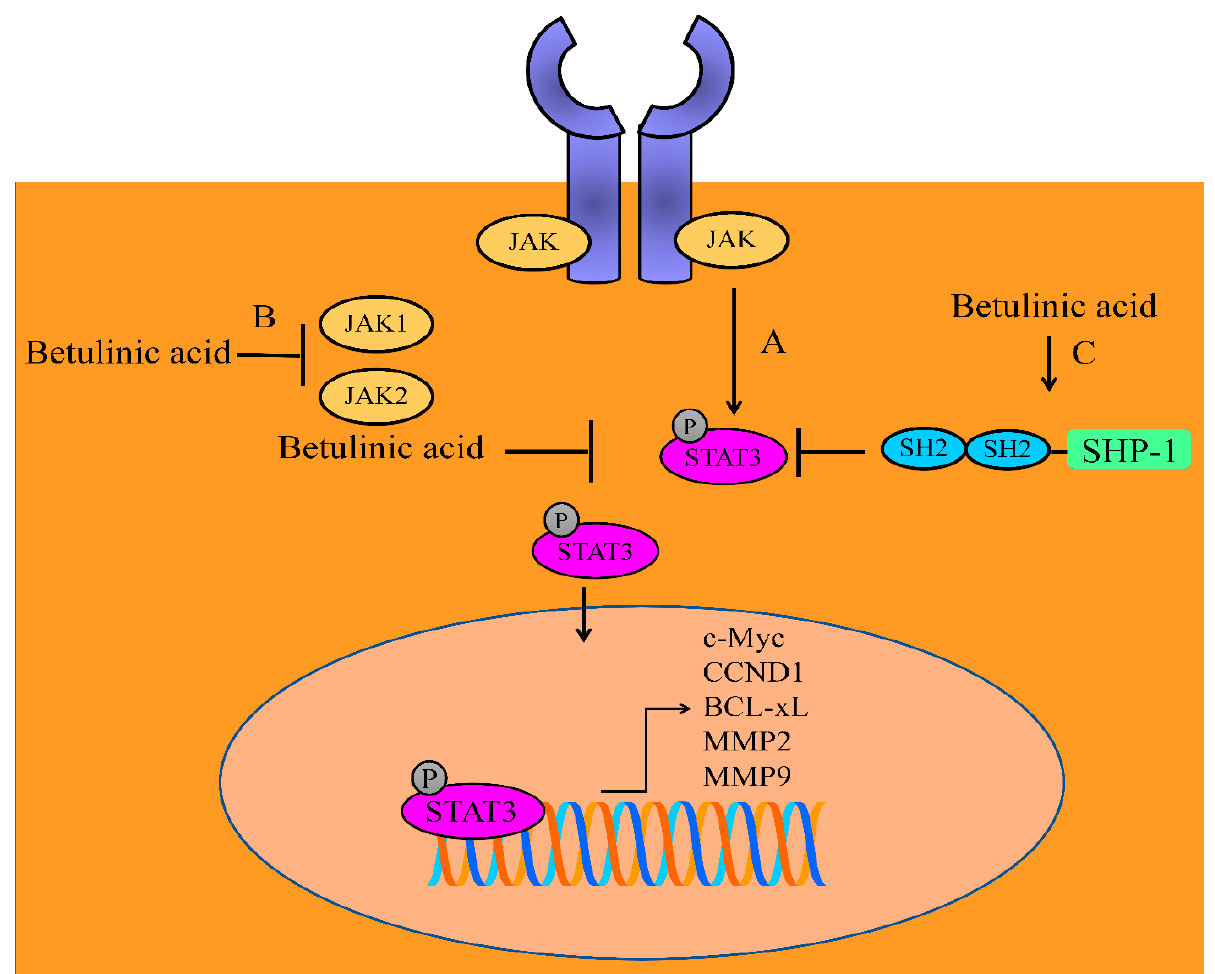
Figure 1. Betulinic acid mediated regulation of JAK/STAT signaling. (A) Janus kinase (JAK)/signal transducer and activator of transcription (STAT) triggered upregulation of target gene network. (B) Betulinic acid inhibited JAK1 and JAK2. (C) Betulinic acid triggered SHP-1 mediated dephosphorylation of STAT3. Abbreviations: CCND1 (Cyclin D1), MMP2/MMP9 (matrix metalloproteinase-2/9), SHP-1 (Src homology region 2 domain-containing phosphatase 1).